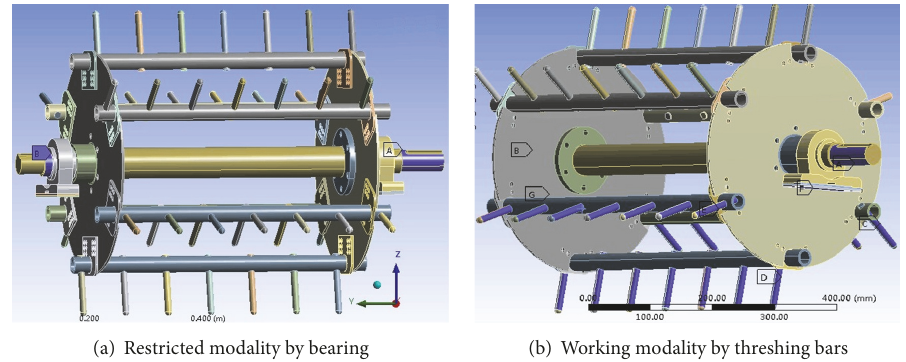
Figure 4: Restricted and working modalities analysis of tangential threshing